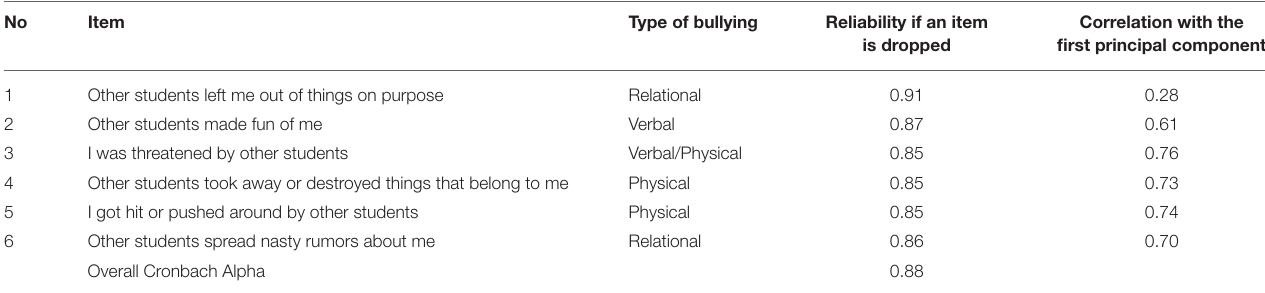
TABLE 2 | Reliability and validity analysis of the scale of the exposure to bullying on the Russian PISA